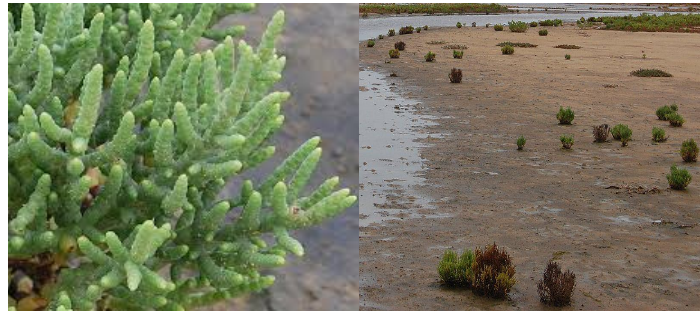
Figure 1. A. indicum